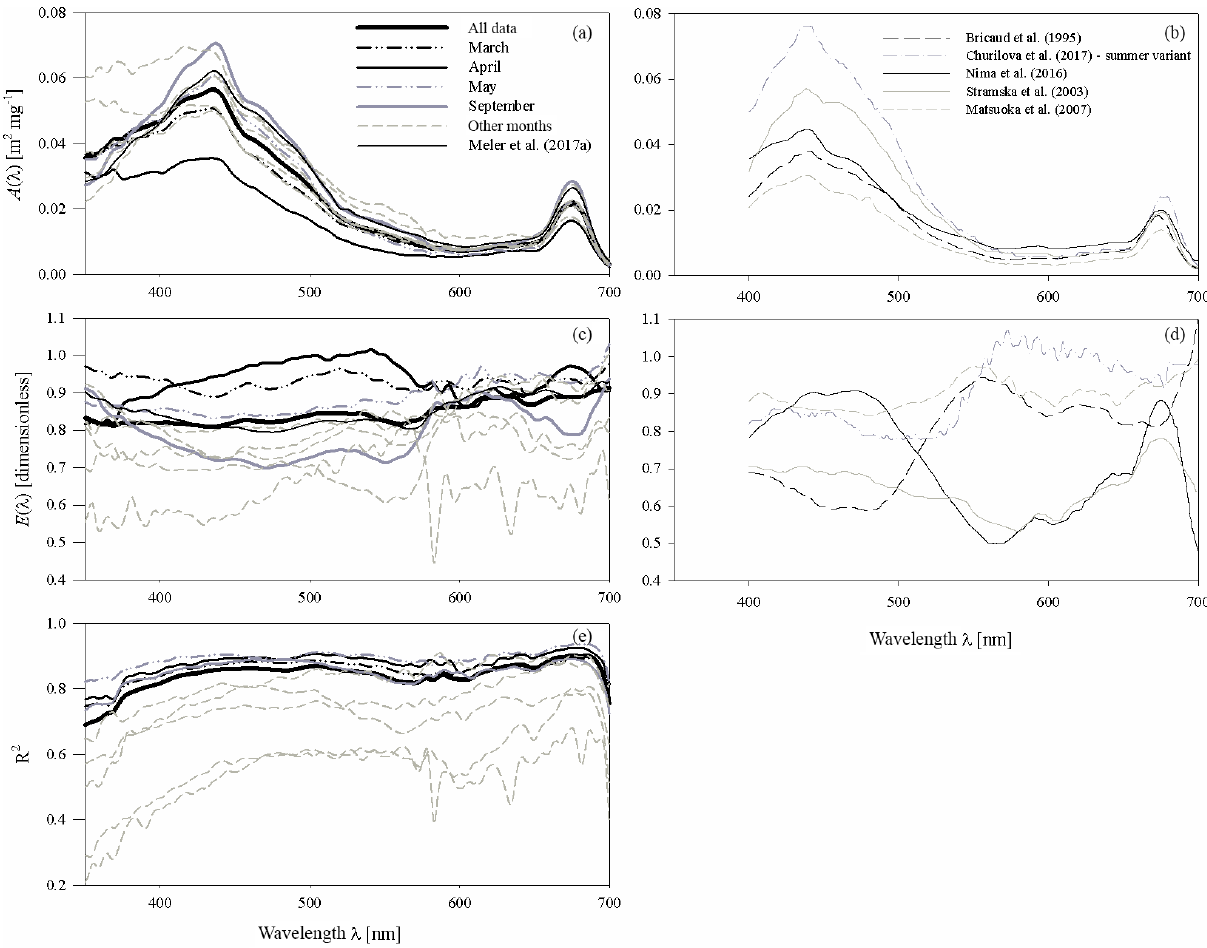
Figure 4. (a, c) Spectral plots of coefficients A and E of the parameterizations described by Eq. (3a), and (e) the corresponding values of coefficient R 2 , determined for all the data analysed and for each sampling month. The coefficients of the preliminary parameterization given in Meler et al. (2017a) are also plotted; (b, d) examples of coefficients A and E given by various authors (the legend is given in b